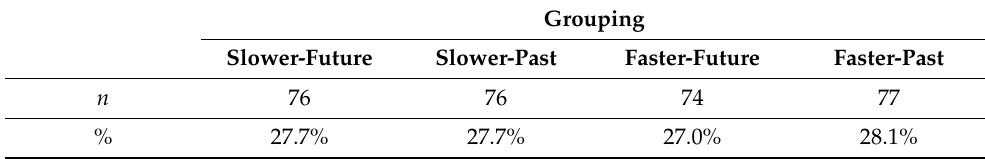
Table 3. Participant’s grouping information ( n =